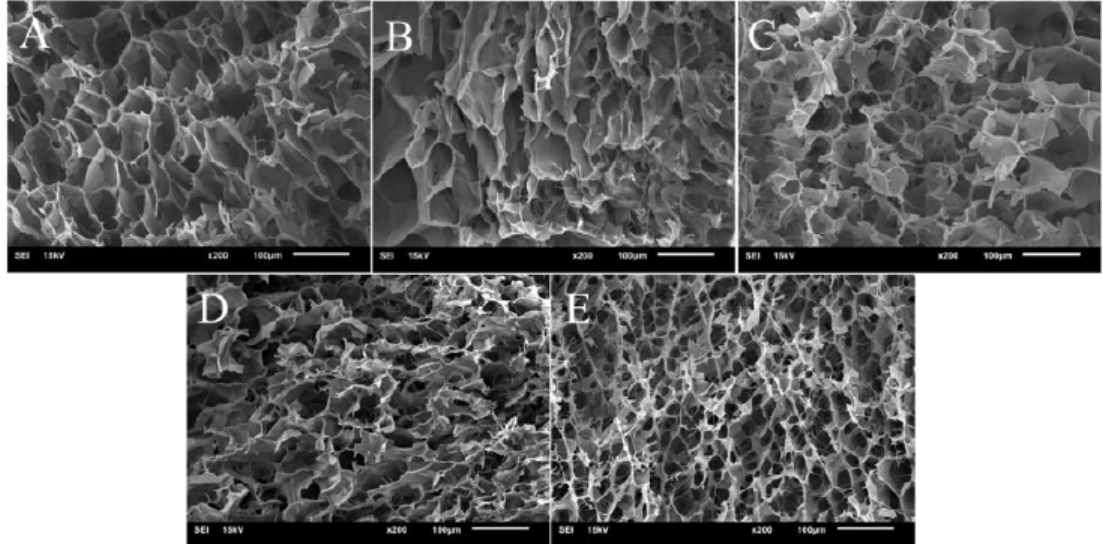
Figure 5. Microstructure of CS/KGM mixtures at different KGM concentrations. ( A ) CS; ( B ) 0.3% KGM; ( C ) 0.6% KGM, ( D ) 0.9% KGM; ( E ) 1.2%